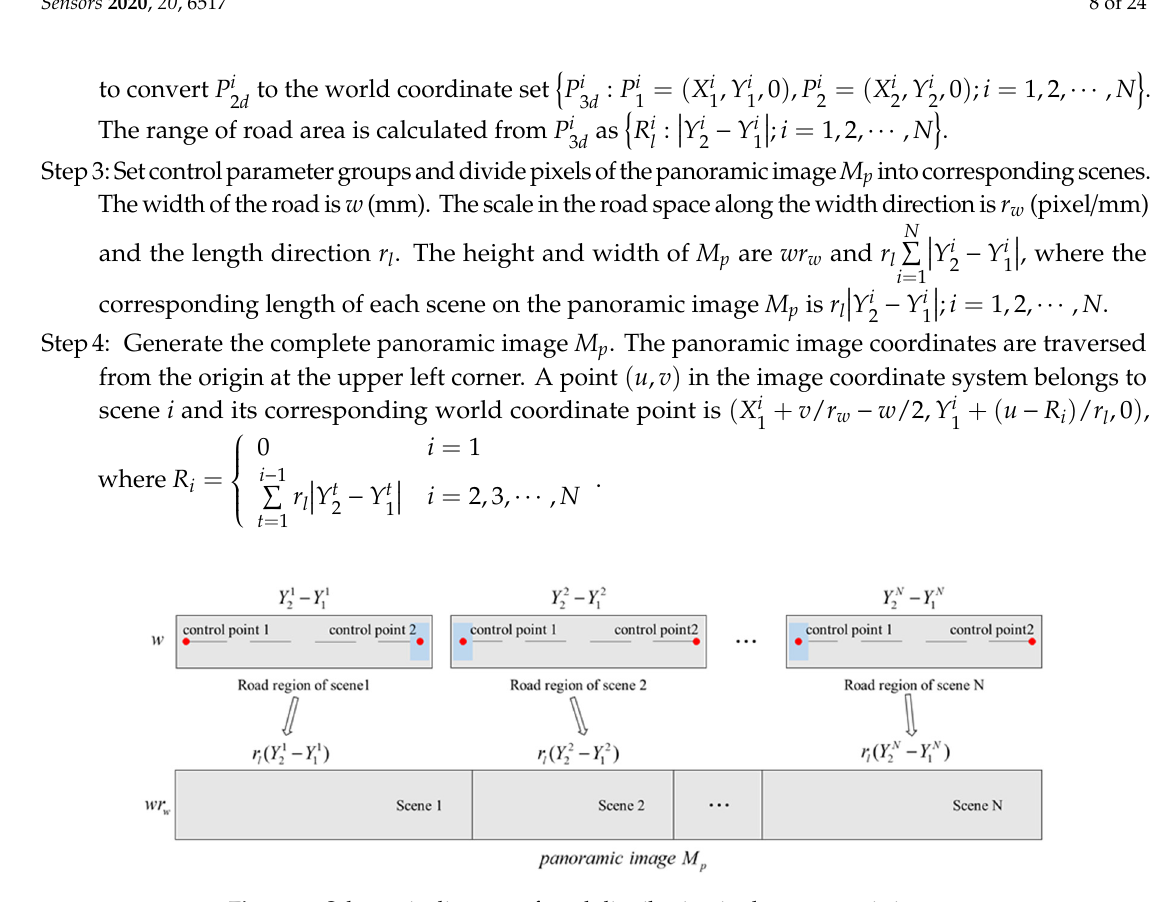
Figure 5. Schematic diagram of road distribution in the panoramic image.